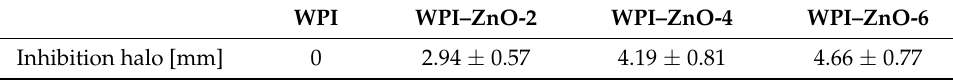
Table 2. Inhibition halos of bionanocomposites against S.epidermidis